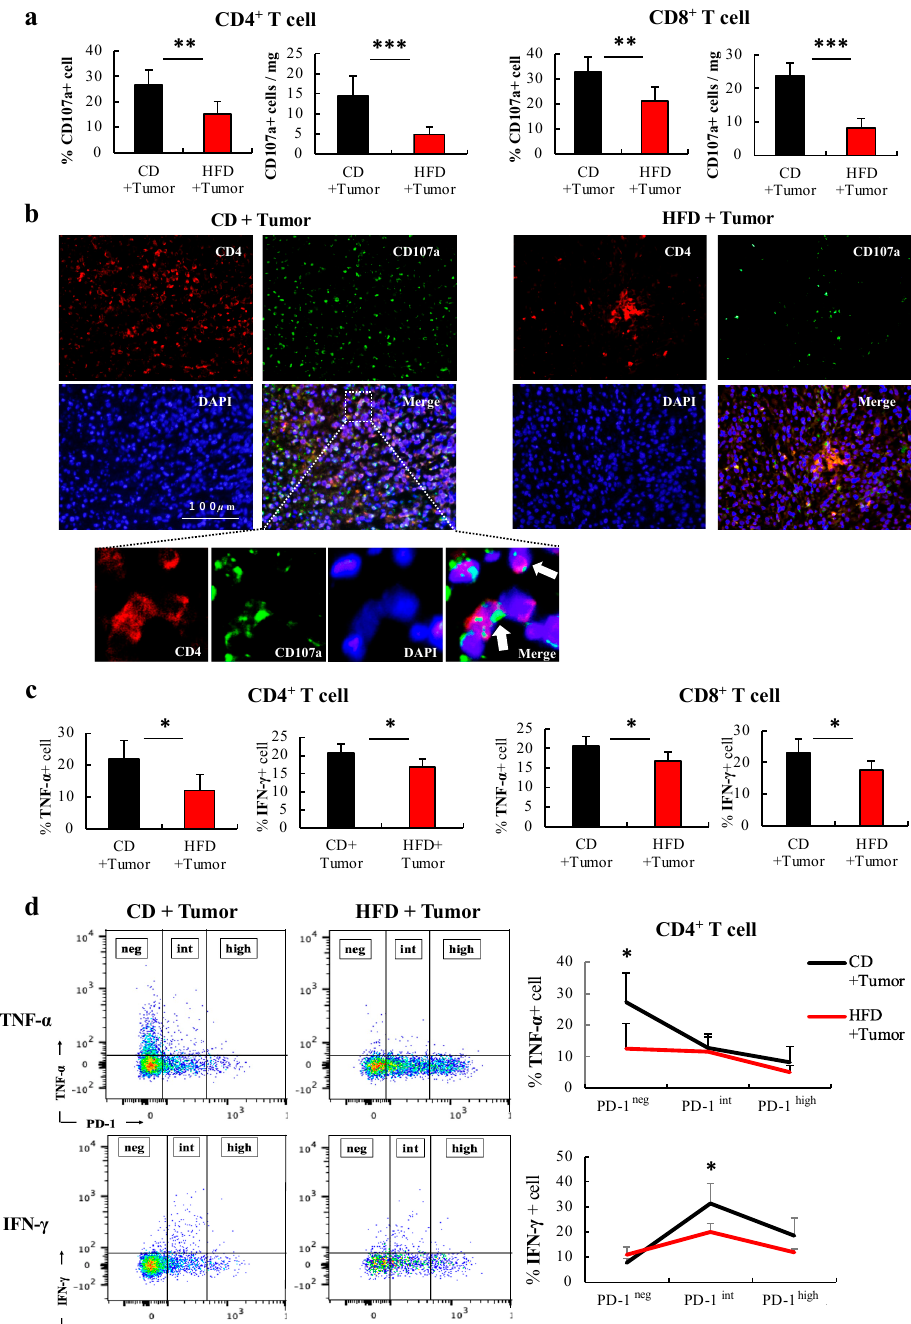
Figure 5. HFD-induced obesity attenuates the cytotoxic activity of CD4+ T cells in tumors. The CD4+ T cells in the tumors of CD-and HFD-fed mice were analyzed after 3 weeks of tumor inoculation. ( a )